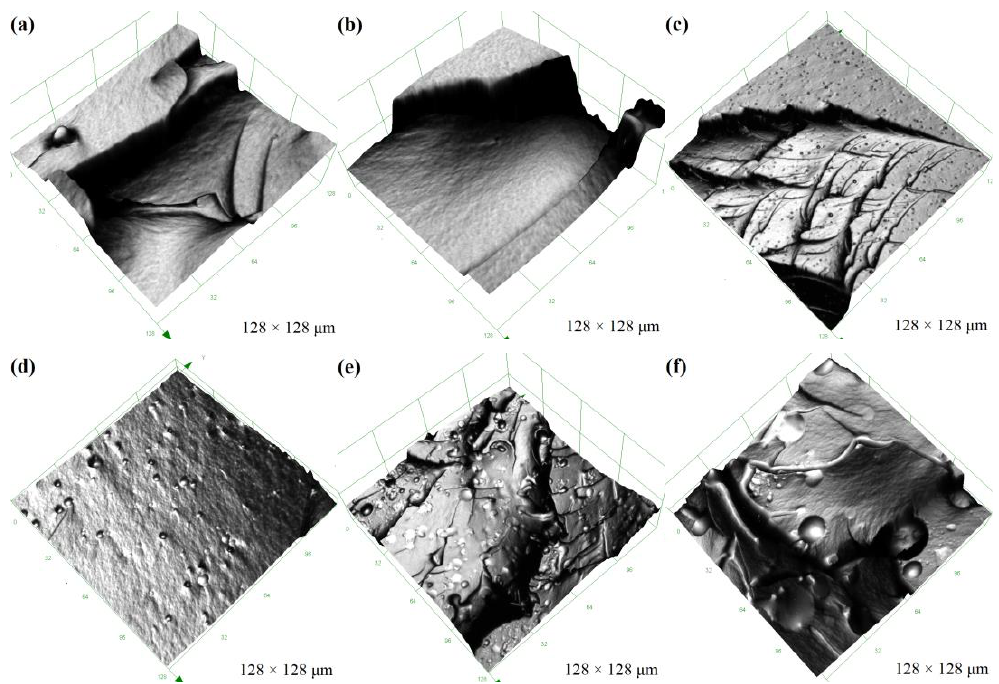
Figure 8. The area coverage of PSO on the surface.